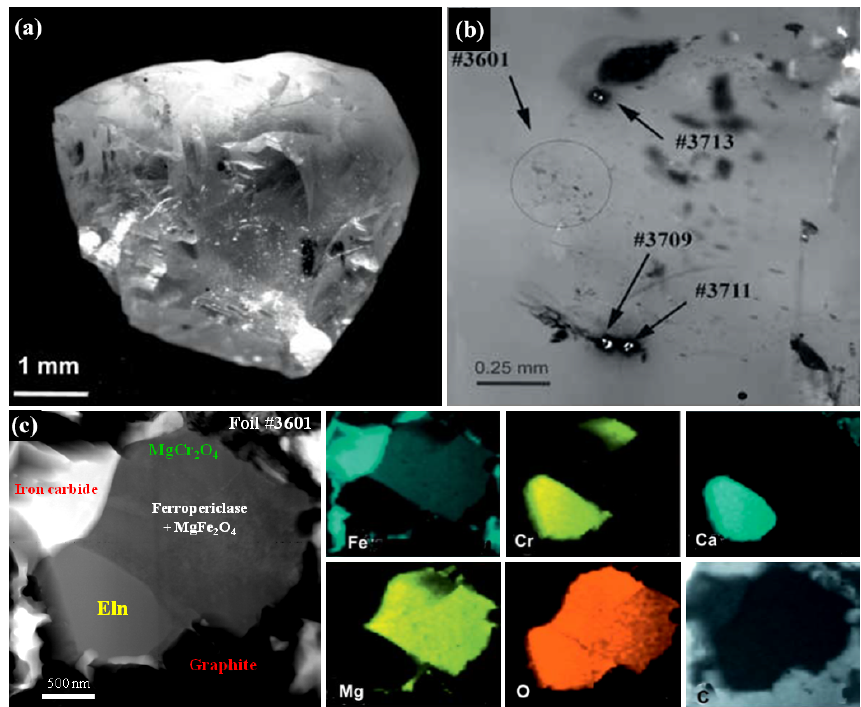
Figure 1. (a) General view of diamond #8-108, Brazil. (b) Positions of TEM foils in the diamond. (c) Polyphase mineral inclusion with ellinaite, foil #3601, TEM image and elemental maps. Symbols: Eln – ellinaite; MgCr 2 O 4 – orthorhombic MgCr 2 O 4 ; MgFe 2 O 4 – magnesioferrite; Iron carbide – Fe 2 (C,N), Fe 3 (C,N) or Fe 7 (C,N) 3 . Data were adapted from Kaminsky et al.